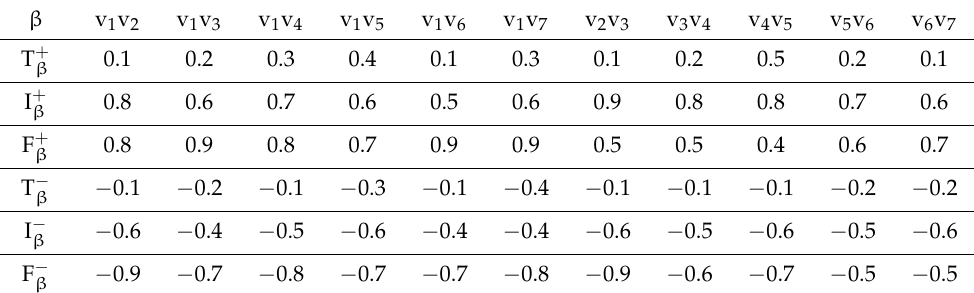
Table 3. The energy of BSVNG relation on